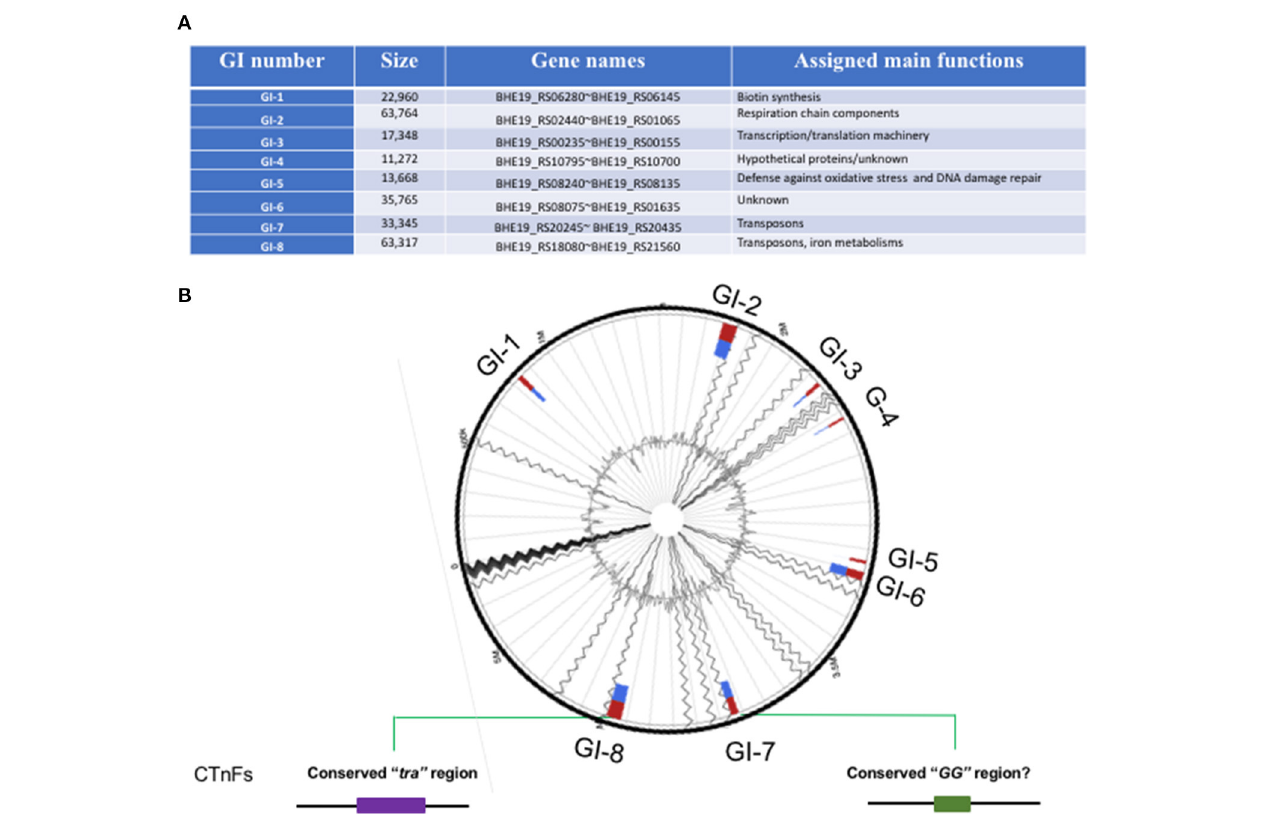
FIGURE 3 | Genomic islands in F. spartansii T16 T . (A) The 8 genomic islands were predicted by Islandviewer. (B) The schematic of GI-associated features. The relative locations of the 8 GIs were shown in the predicted genome. The conjugation protein genes belonging to “ tra ” and “ GG ” in CTnFs were centered in the GI-7 and GI-8 regions,